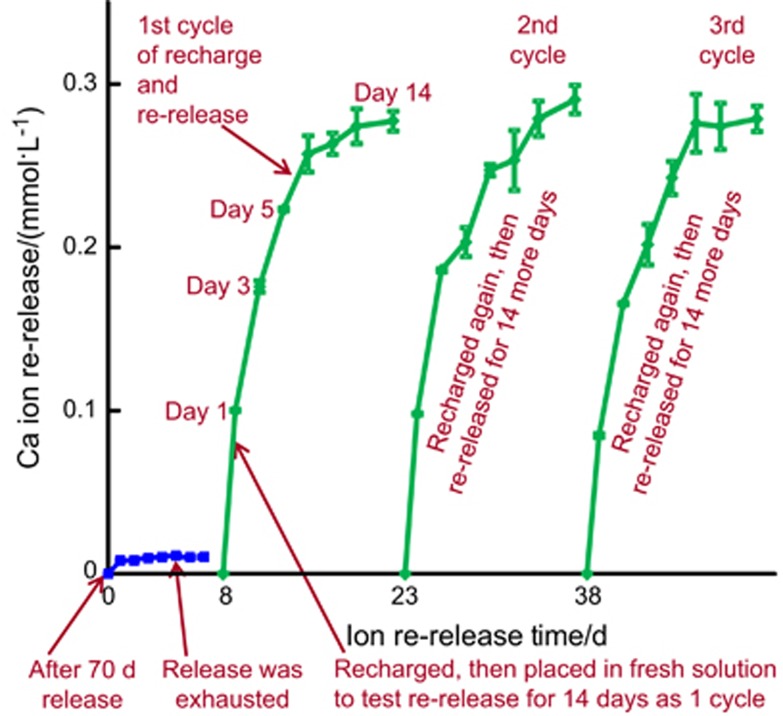
Illustration of Ca and P ion recharge and re-release. NACP-containing cement specimens were first immersed in pH 4 solution for 70 days to exhaust the ion release, as indicated by the lower left arrow. Then, the specimens were immersed in fresh pH 4 solution to confirm that the ion release was indeed exhausted, as indicated by the lower middle arrow. The exhausted specimens were recharged in a recharge solution. The recharged specimens were tested for Ca and P ion re-release for 14 days, as indicated by the lower right arrow. This constituted the first recharge/re-release cycle. This was repeated for three cycles. Ca, calcium, NACP, nanoparticles of amorphous calcium phosphate; P, phosphorus.